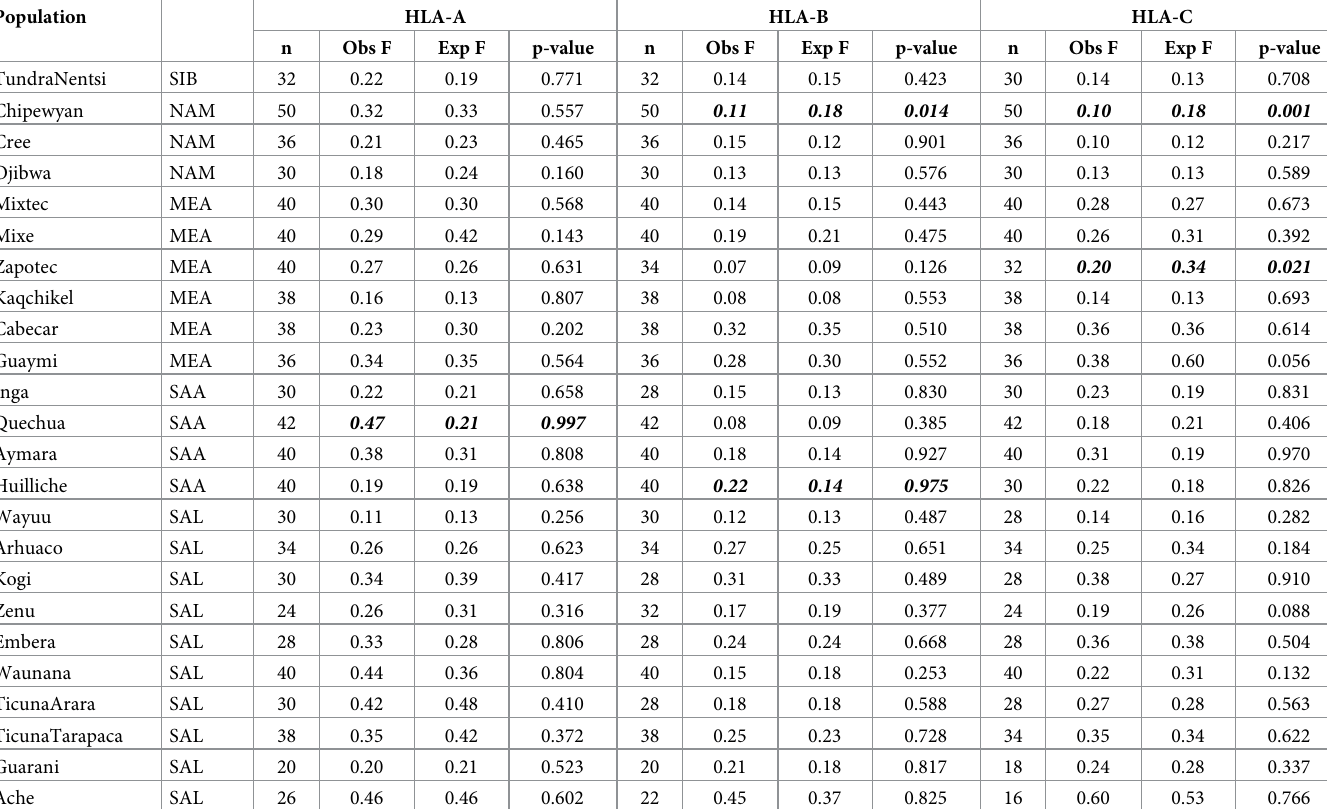
Table 3. Ewens-Watterson neutrality test a